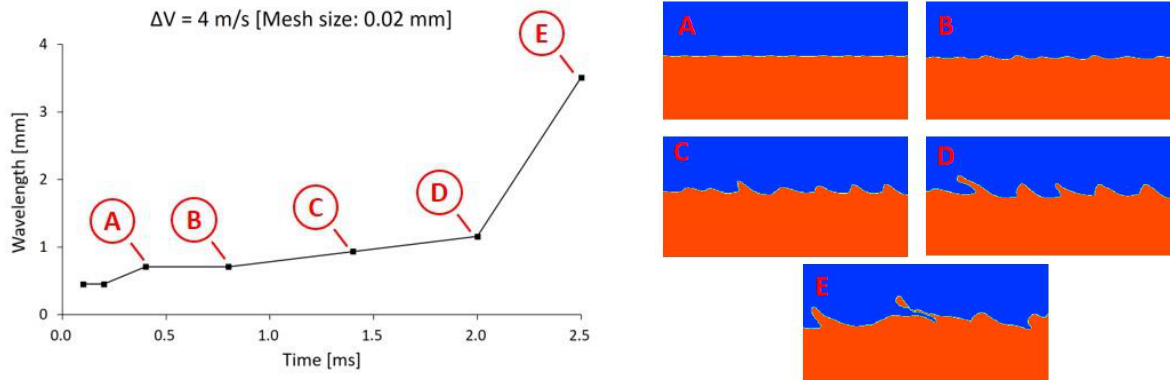
Figure 8. Fastest growing wavelength v.s. time ( left ) and corresponding contour of volume fraction ( right ) in Kelvin–Helmholtz instability ( ∆ V = 4 m/s); the contour size is 3.0 mm vertically and 6.2 mm horizontally. These correspond to 150 vertical and 310 horizontal mesh elements.